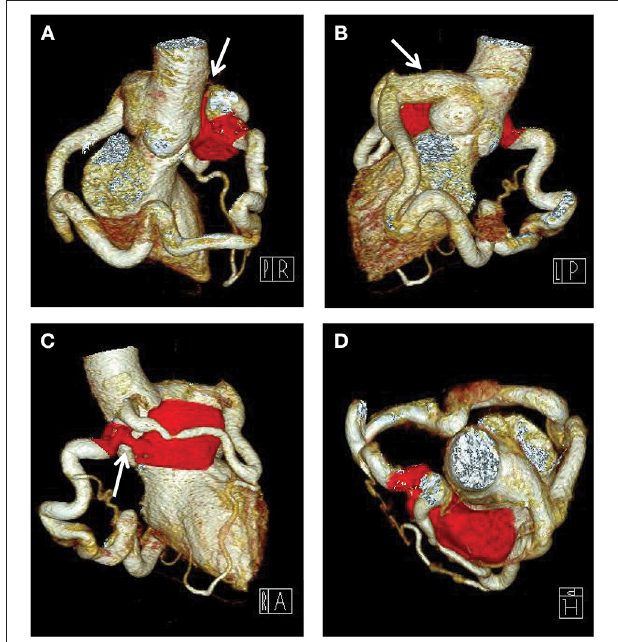
FIGURE 1 | Computed tomography angiography preoperatively showing that there is an interruption between right sinus of Valsalva and the enlarged and tortuous right main coronary artery ( A , arrow), a single left coronary ostium with a giant coronary trunk ( B , arrow), a 7-mm fistula into the right ventricle (Red) ( C , arrow), the left and right coronary artery were connected with each other and formed a closed loop at the base of the heart (D) .